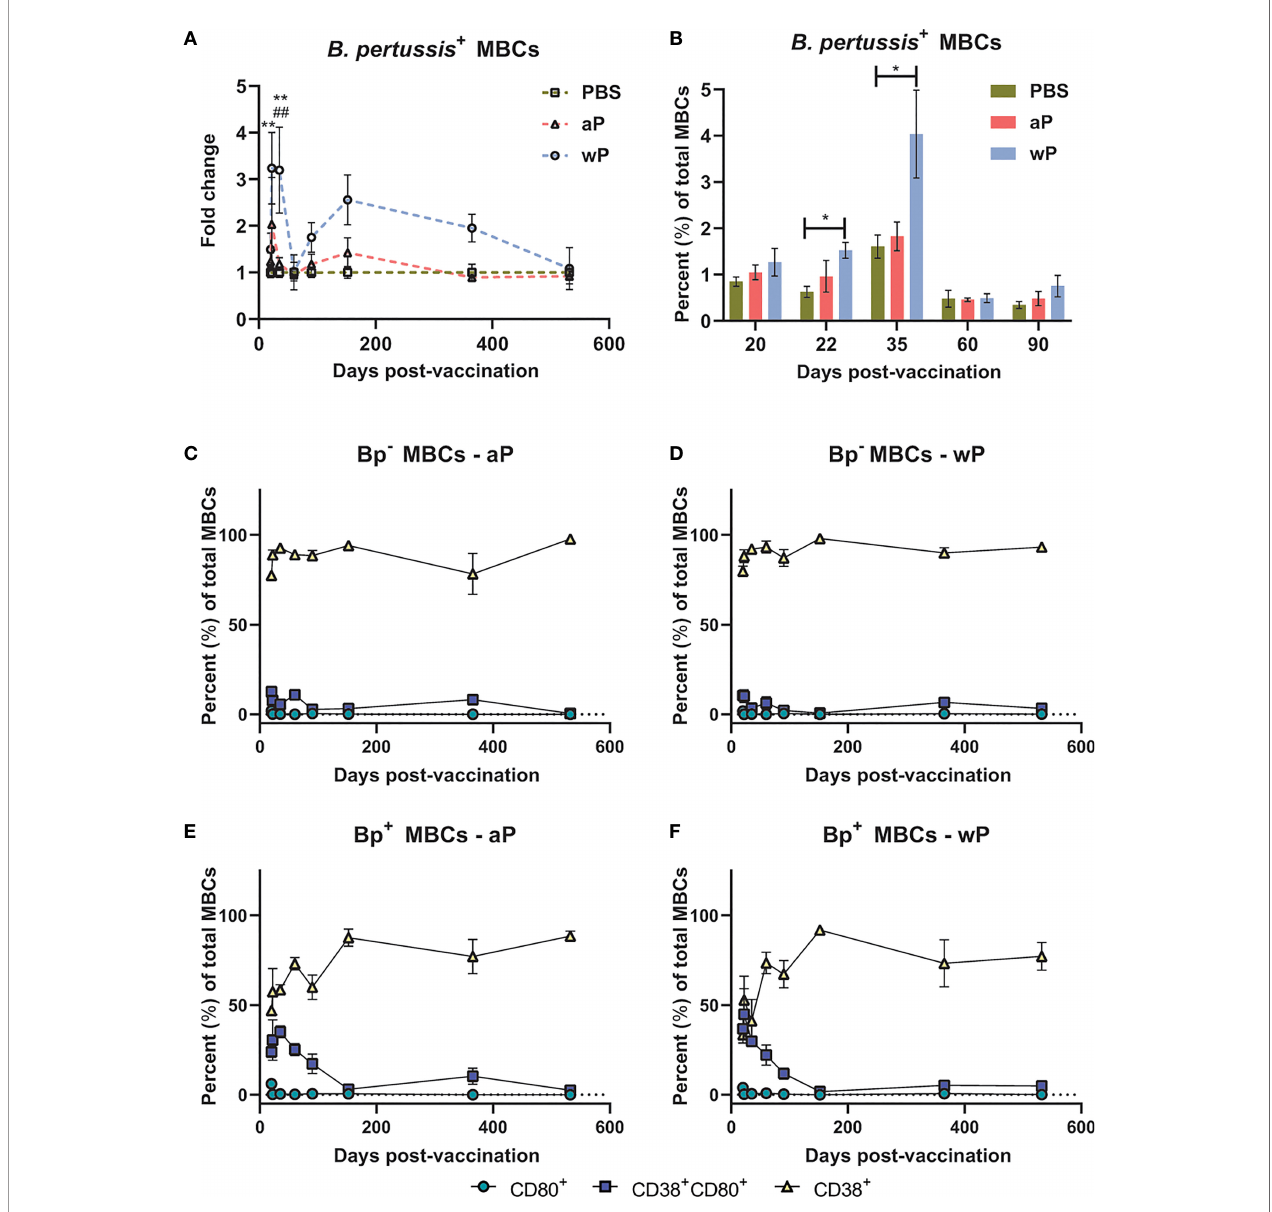
FIGURE 4 | B. pertussis + memory B cells are elevated in wP immunized CD1 mice. Flow cytometry was performed using single cell suspensions from the spleen of immunized non-challenged mice. B. pertussis + MBCs were identi fi ed following the protocol outlined in the methods. Extracellular markers were used to label B. pertussis + MBCs. (A) Fold change of B. pertussis + MBCs in aP and wP groups compared to PBS-vaccinated mice. (B) Percent total B. pertussis + MBCs. (C – F) show the percent of CD80 + , CD38 + CD80 + , and CD38 + MBCs in immunized mice. (C) B. pertussis - MBCs in aP immunized animals. (D) B. pertussis - MBCs in wP immunized animals. (E) B. pertussis + MBCs in aP immunized animals. (F) B. pertussis + MBCs in wP immunized animals. Days 20, 60, 152, 365 (n=8), and 532 are from one independent experiment each (n=4). Days 22, 35, and 90 are from two independent experiments (n=8). The p-values were calculated for each time point using